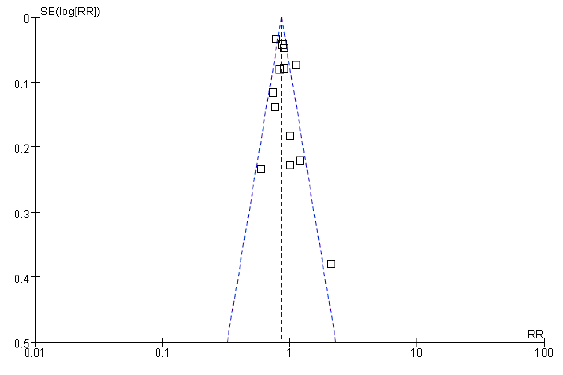
Figure 1. Funnel plot of studies of coffee consumption and stroke risk.